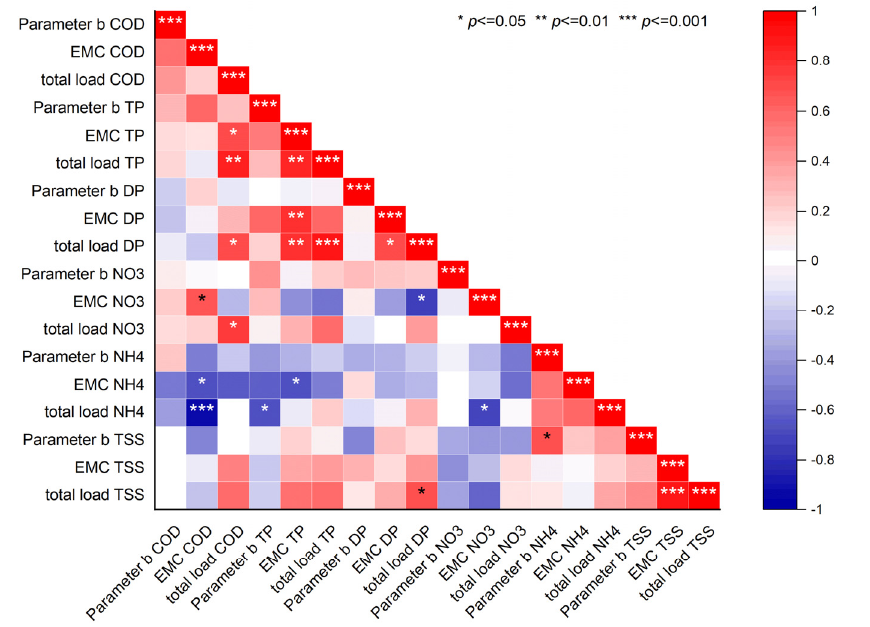
Figure 4. Correlation pattern for investigated pollutants with parameter b , pollutant EMCs and total pollutant loads with level of significance * = p ≤ 0.05, ** = p ≤ 0.01 and *** = p ≤ 0.001. Red squares indicating a positive, blue squares indicating a negative correlation coefficient, respectively.